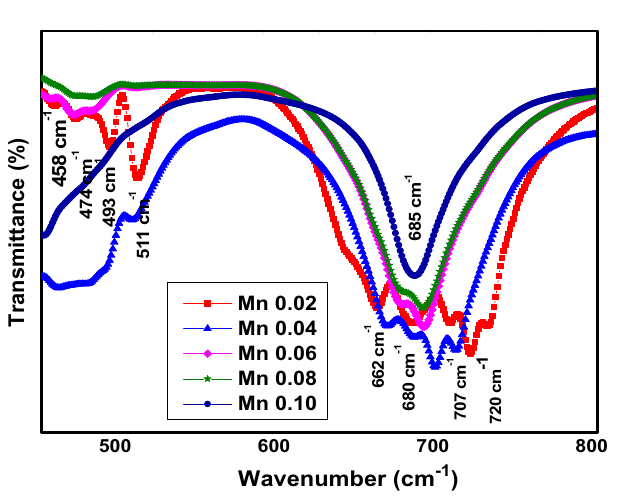
Figure 3. FTIR spectrum of SrLaLiTe 1− x Mn x O 6 .